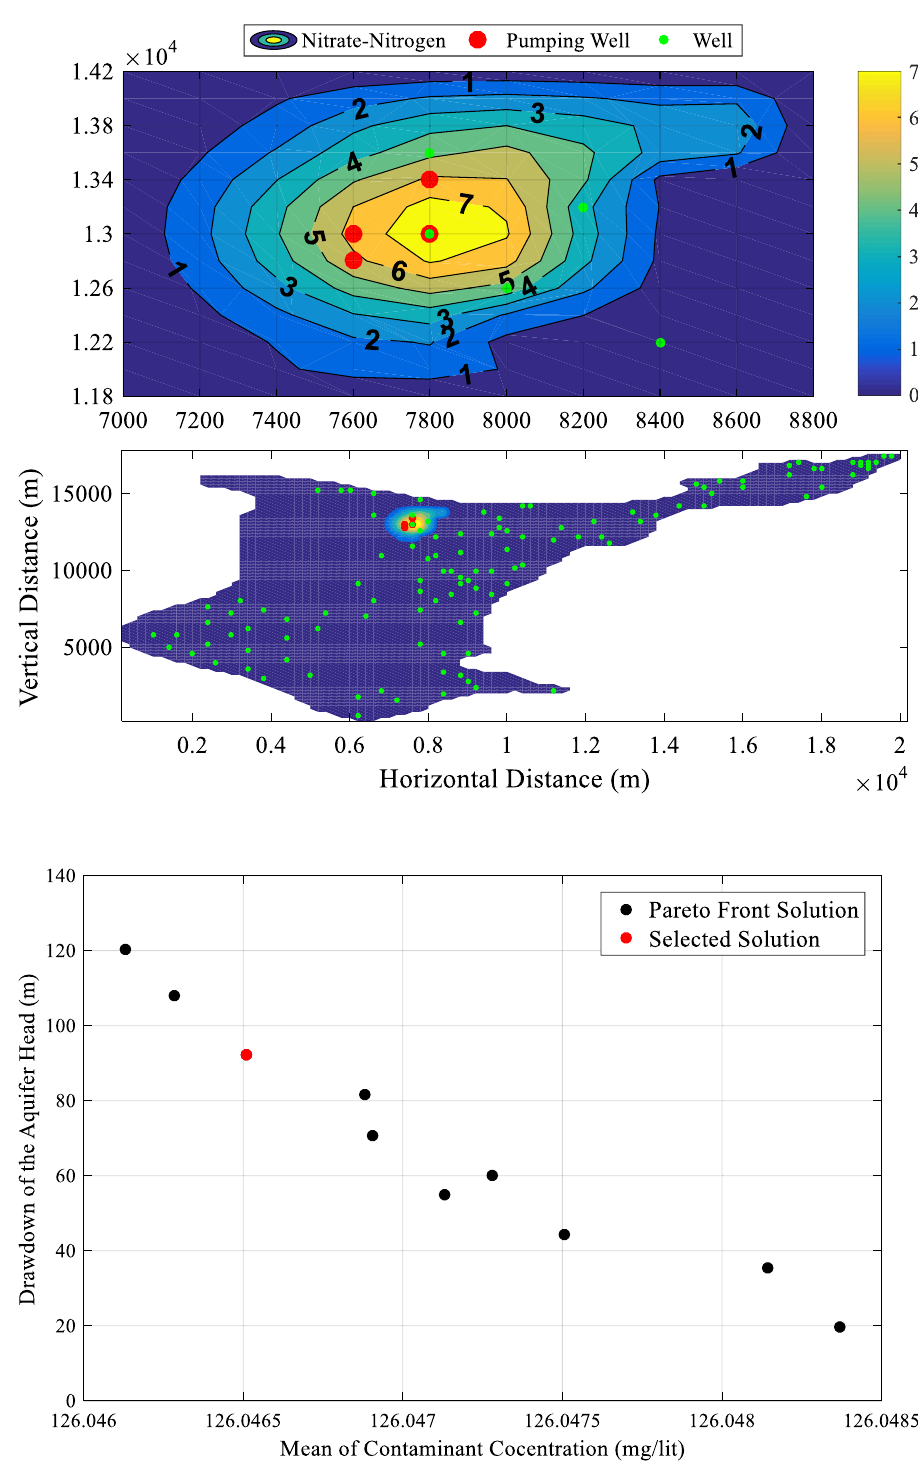
Fig. 14 Contaminant distribu- tion after 3 years remediation